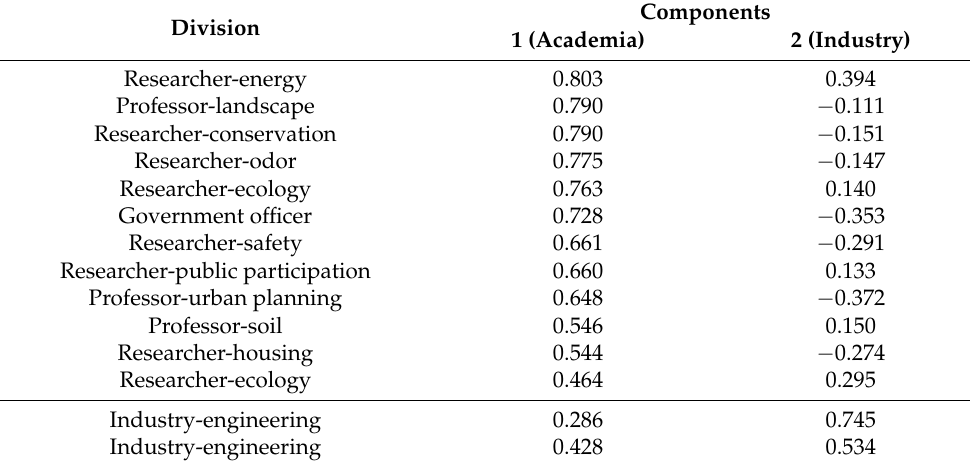
Table 4. Component